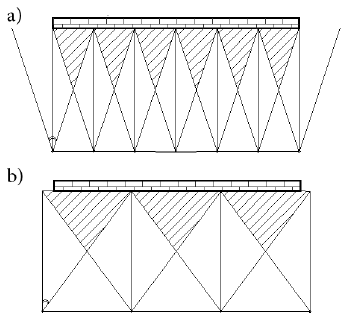
Figure 9. Comparison of the effectiveness of normal: a – and convergent; b – survey